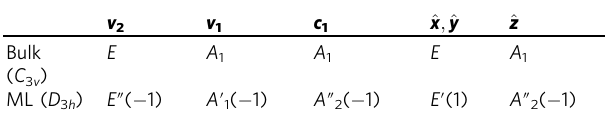
Group representation of the valence ( v 2 and v 1 ) and conductionband ( c 1 ) states for MLand bulk InSe, togetherwith the representation of the dipole operators ^ x ; ^ y and ^ z , corresponding to IP and OP emitting dipoles, respectively. The even and odd character of valence and conduction band states at Γ point under in-plane mirror symmetry is indicated within parentheses ML monolayer, IP in-plane, OP